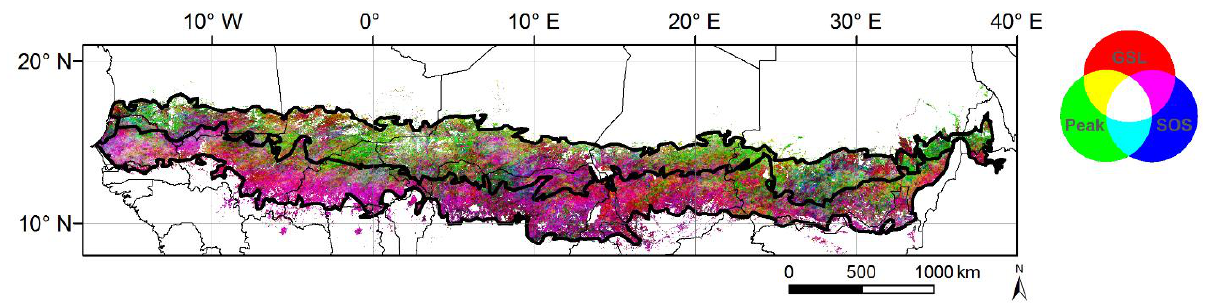
Figure 3. Visualization of the correlation between CFAPAR vs. GSL, Peak value and ΔSOS in the RGB color space. The composite is based upon the coefficients of determination ( R 2 ) of the linear regression CFAPAR vs. GSL (Red), Peak (Green) and ΔSOS (Blue); no stretching is applied. Main land cover types are represented by the thick black lines (two simplified polygons, herbaceous cover in the north and crop cover in the